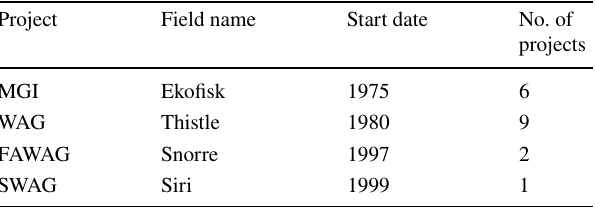
Table 1 Start date of the first projects of each of the EOR schemes in the North Sea. Reproduced with permission from Awan et al. (2008) Project